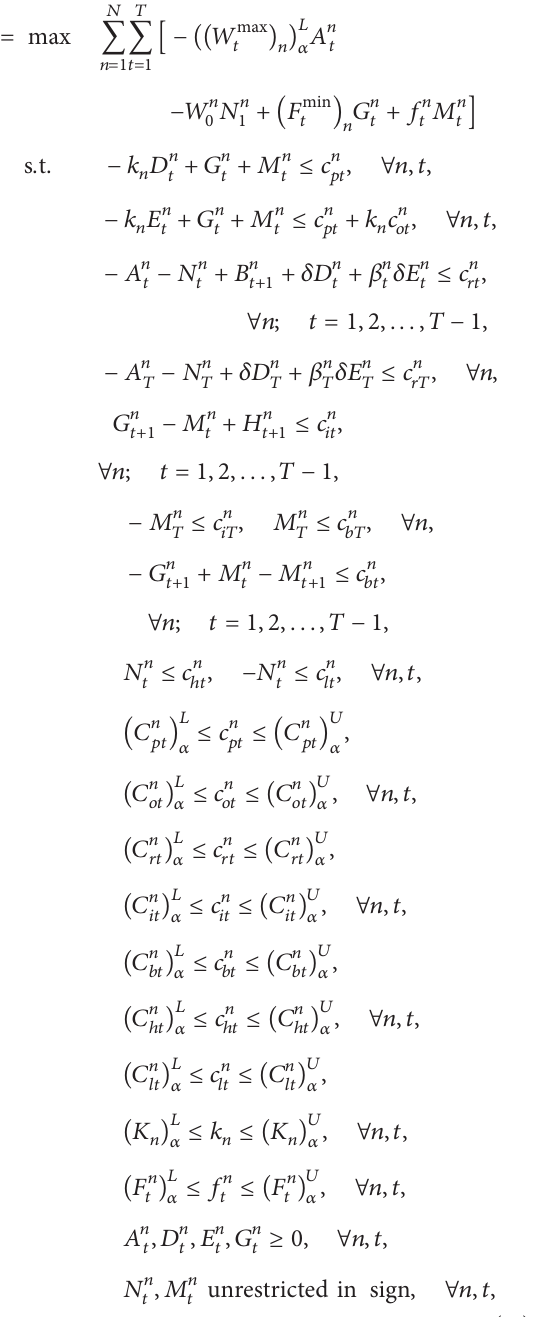
Table 4: Fuzzy overtime labour cost and inventory carrying